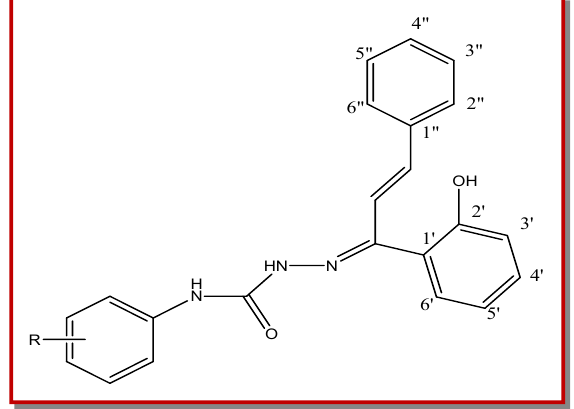
Figure 3: Structure of synthesized semicarbazone